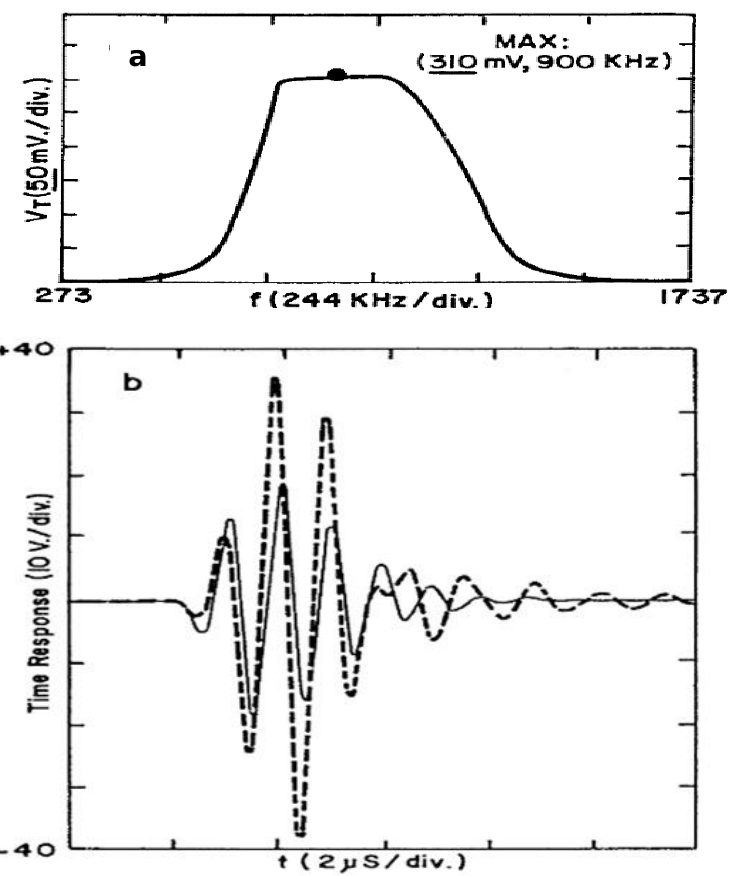
Figure 12. Improvements in the ultrasonic signal measured in T–T through a PMMA piece, due to our tuned HV capacitive driver: ( a ) bandwidth; ( b ) time response with tuning (in dashed line).